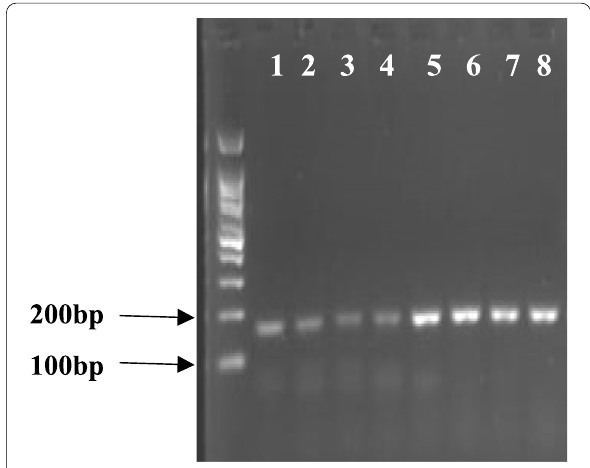
Fig. 10 Real-time-PCR (RT-PCR) of PEPC gene under normal